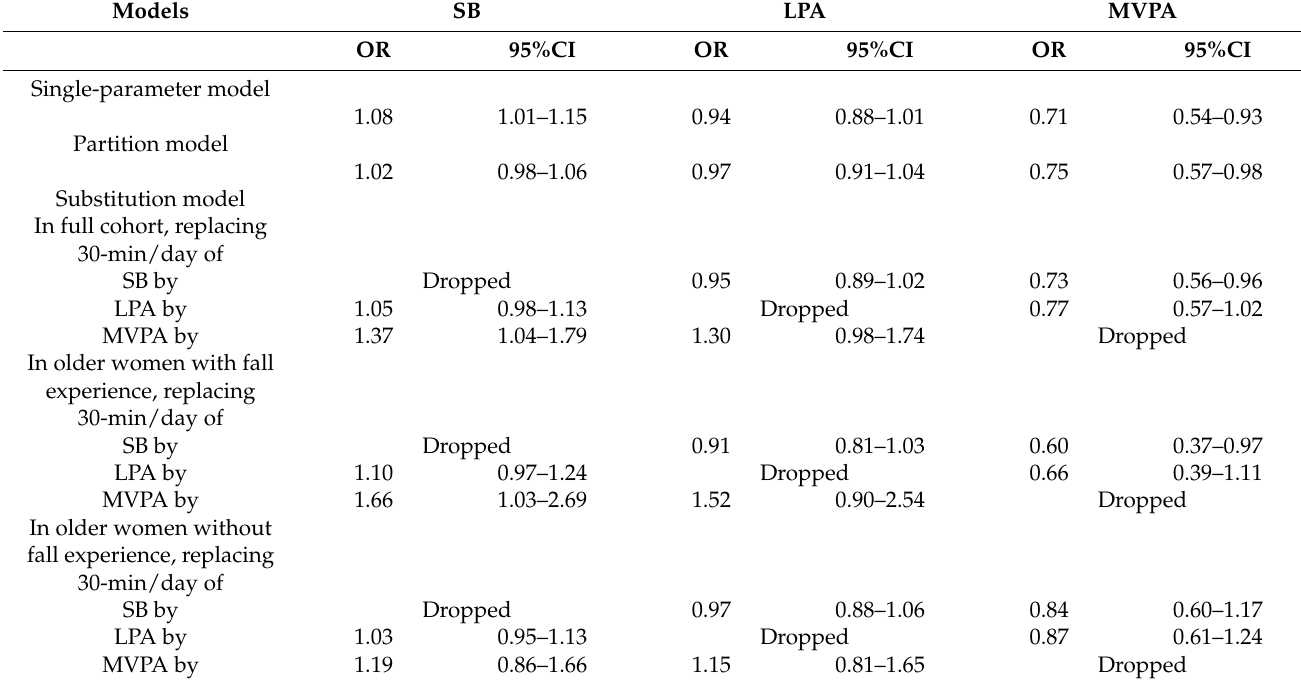
Table 2. Isotemporal substitution models of PA and SB on FOF ( n = 1114; collected from March